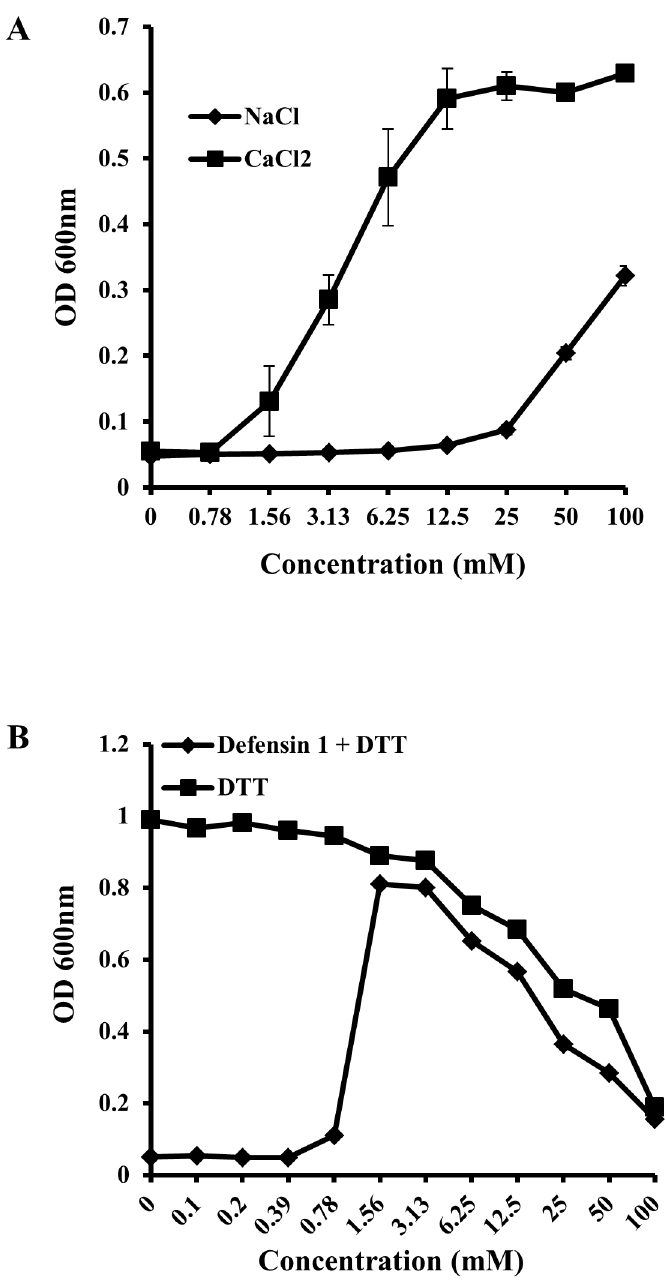
Fig 2. Antimicrobial activity of defensin 1 in the presence of salts and reducing agent. MW2 cells suspended in MH broth were treated with defensin 1 at a constant concentration of 64 μ g/ml together with serial dilutions of NaCl or MgCl 2 (A) ; or treated with serial dilutions of the reducing agent DTT (B) . The OD 600 was measured after overnight incubation at